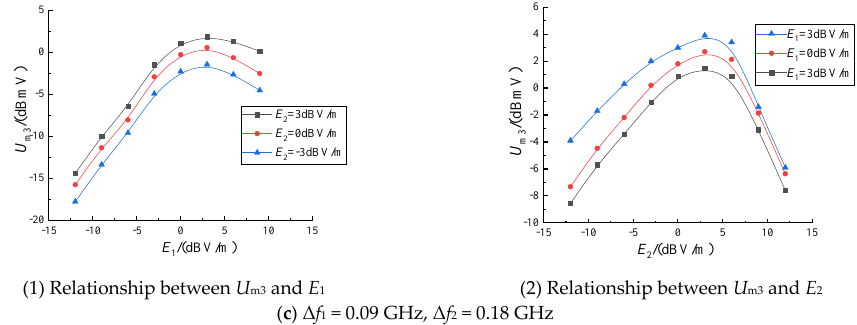
Figure 3. Variation of the IMFA − 3 level changing with single interference component.